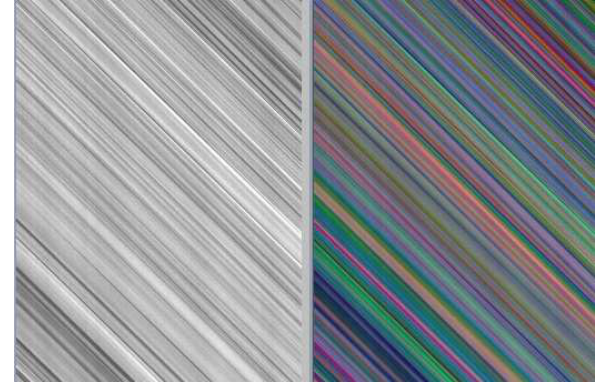
Figure 8 : example of AMETHIST PA and XS images